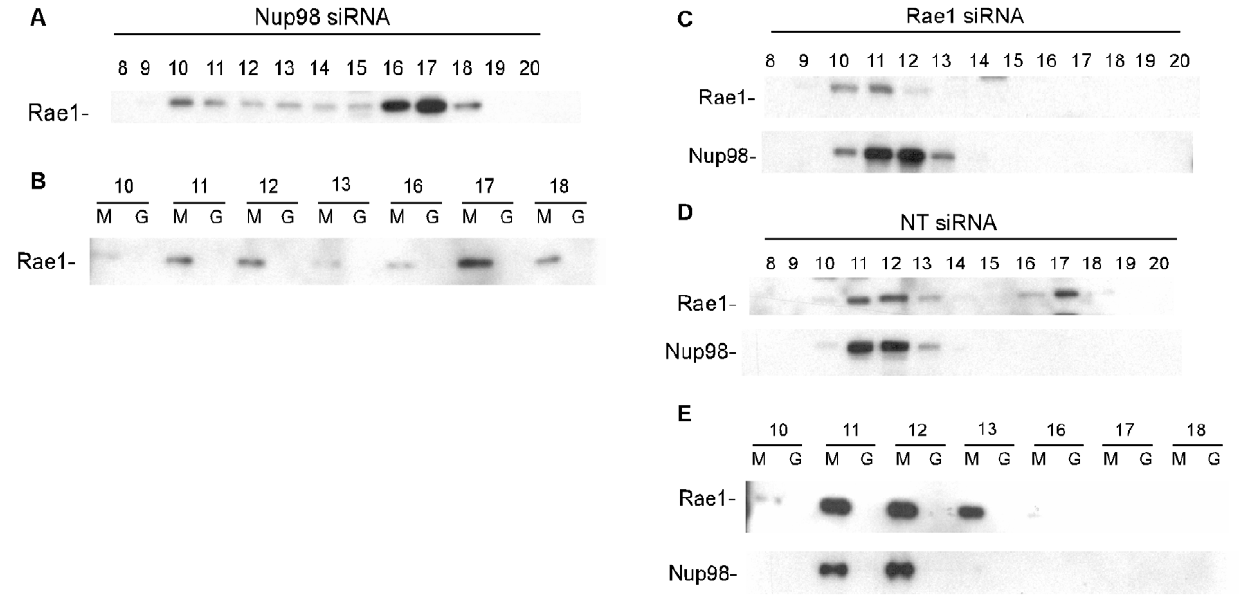
Figure 4. Effects of silencing the expression of Nup98 or Rae1 on complexes containing Rae1. HeLa cells were transfected with Nup98 siRNA ( A ), Rae1 siRNA ( C ), or non-targeting siRNA ( D ). 48 hours post-transfection, lysates were chromatographed on a Superdex 200 column. Fractions were analyzed by immunoblots probed for the indicated proteins. ( B ) and ( E ): Column fractions from ( A ) and ( D ), respectively, were incubated with GST-M protein (M) or GST (G) on glutathione beads for 1 hour, and bound fractions were analyzed by immunoblots probed for Rae1 and Nup98.